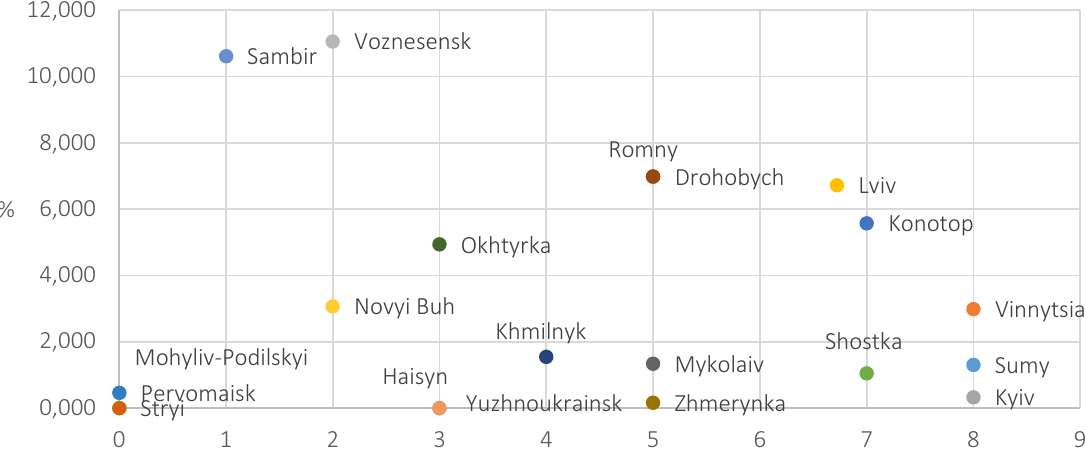
Figure 2. The ratio of the official site ranking to the percentage of population